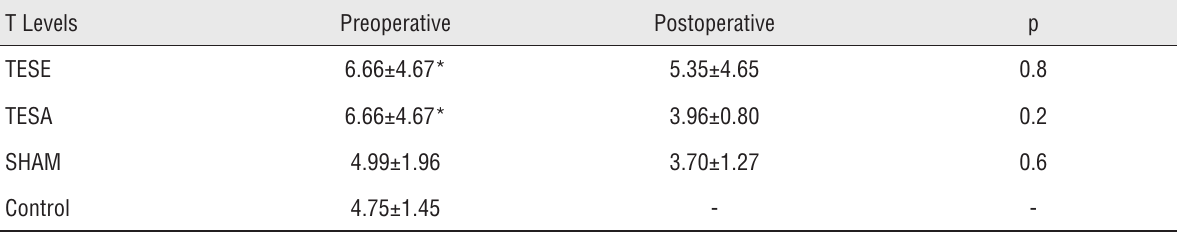
Table 1 - Testosterone levels among experimental animal groups. T Levels